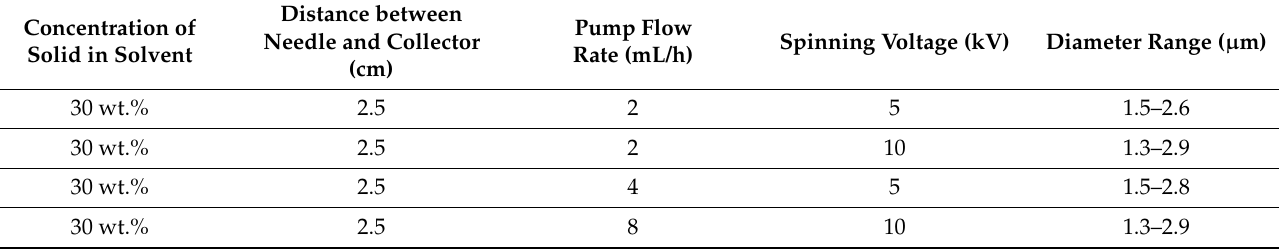
Table 2. Parameters used to electrospun of A85 + 10 wt.% Carbon black fiber (needle diameter: 2 mm). Concentration of Solid in